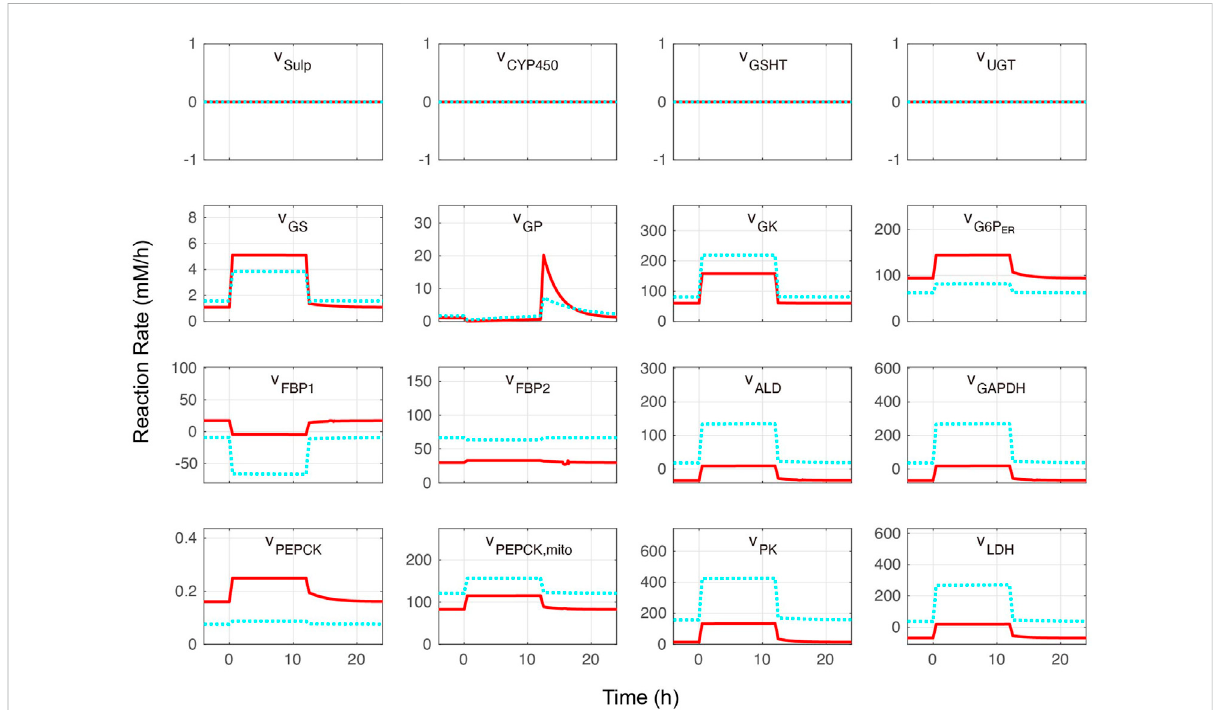
FIGURE 3 Metabolite reaction rates without acetaminophen administration. Hepatocytes were in a feeding state from 0 to 12 h and in a fasting state for the rest of the simulation time. The external (blood) glucose levels were set to 4 and 11 mM for the fasting and feeding states, respectively. The solid red lines and blue dotted lines indicate the periportal and pericentral regions, respectively. The de fi nitions of the abbreviations are listed in Supplementary Material.